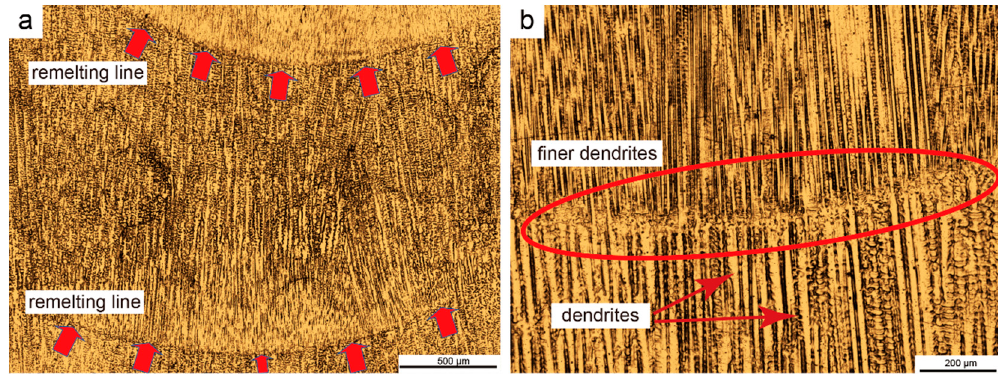
Figure 4. Microstructure of CMT+P as-deposited wall: ( a ) Periodic layer belt microstructure, and ( b ) epitaxial growth morphology of grains in the remelting line.